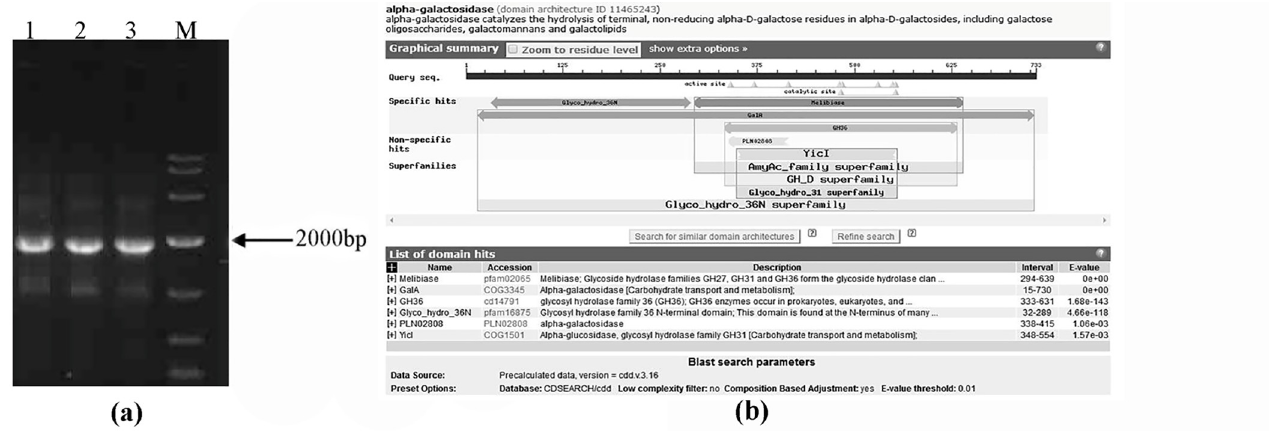
Fig 1. Gel electrophoresis of PCR products of α -gal gene. (a) (lane 1–3 represent PCR products of α -gal gene, M represents DNA Marker DL2000) and amino acid sequences analysis of AglB by BLASTn.